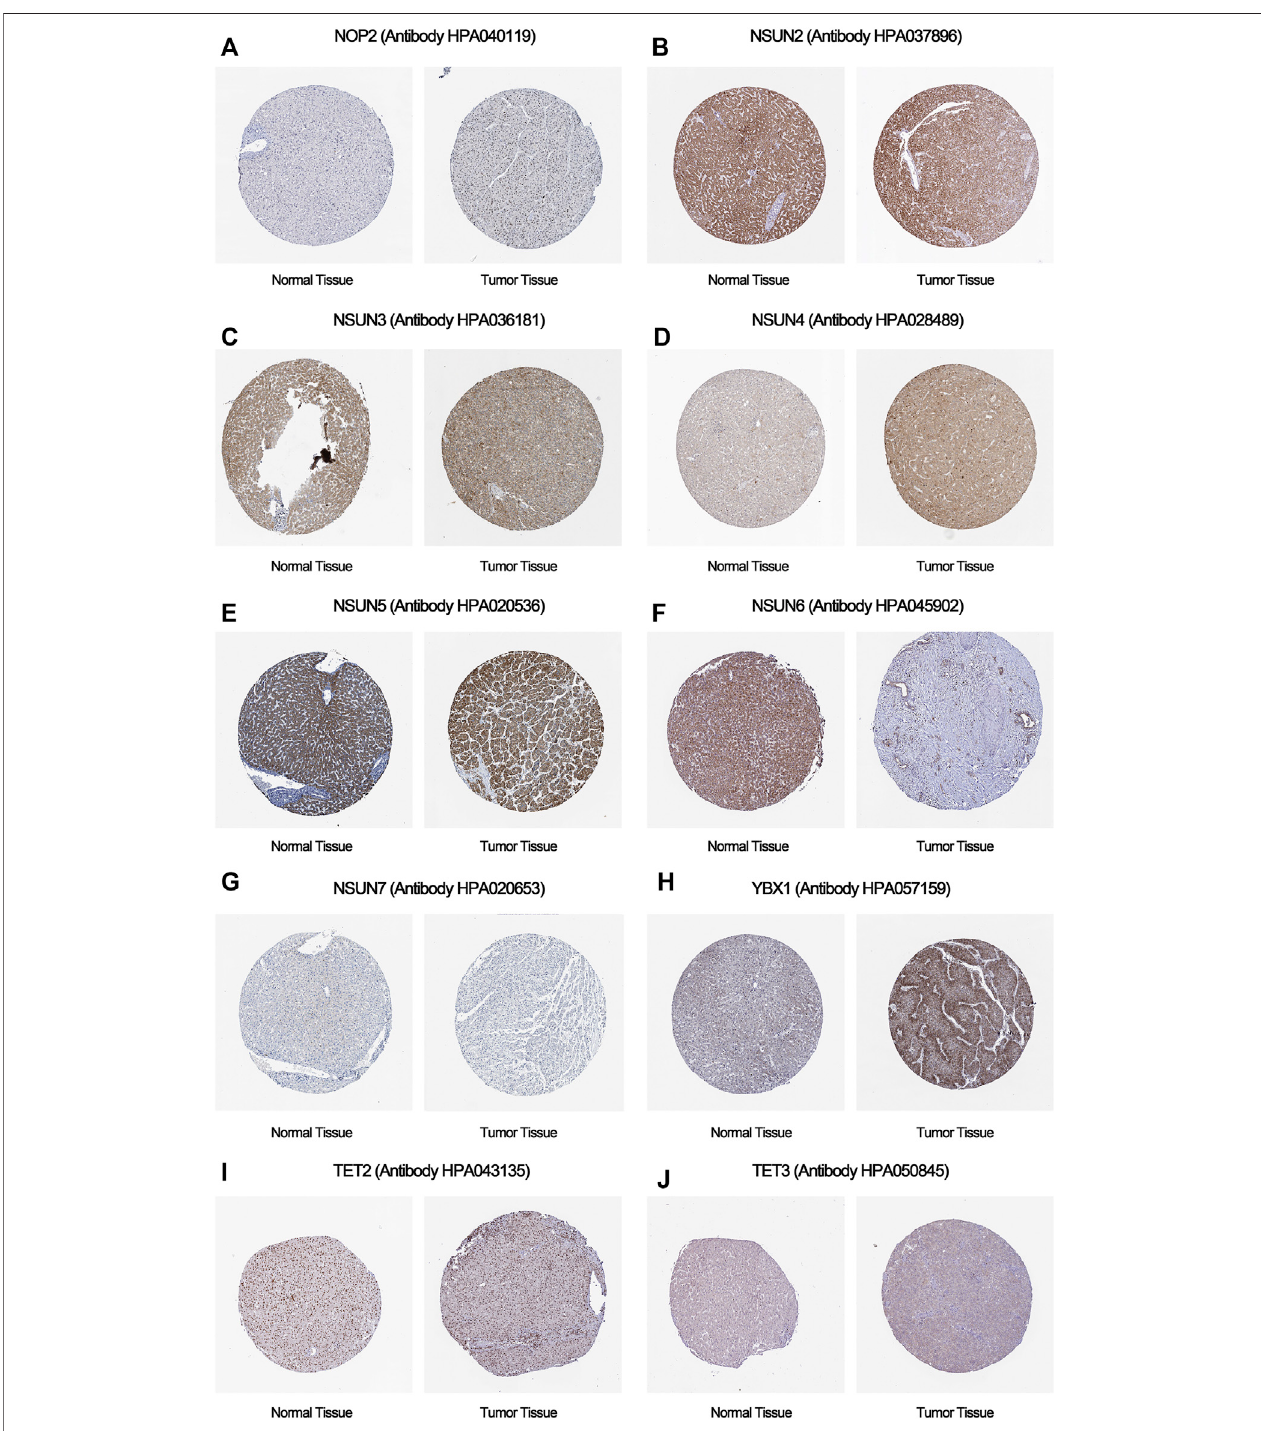
FIGURE 9 | The protein expression of m5C regulators in HCC and normal tissues. (A) The protein expression of NOP2 in HCC and normal tissues; (B) The protein expression of NSUN2 in HCC and normal tissues; (C) The protein expression of NSUN3 in HCC and normal tissues; (D) The protein expression of NSUN4 in HCC and normal tissues; (E) The protein expression of NSUN5 in HCC and normal tissues; (F) The protein expression of NSUN6 in HCC and normal tissues; (G) The protein expression of NSUN7 in HCC and normal tissues; (H) The protein expression of YBX1 in HCC and normal tissues; (I) The protein expression of TET2 in HCC and normal tissues; (J) The protein expression of TET3 in HCC and normal tissues.